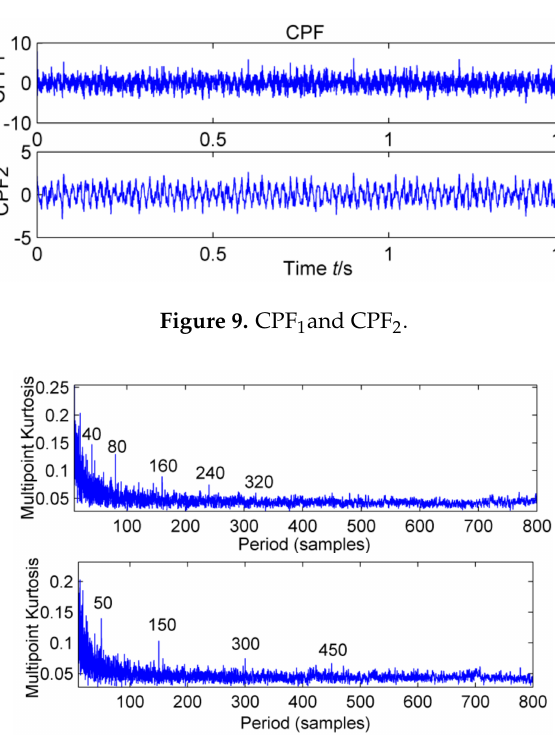
Figure 10. Multi-point kurtosis spectra of CPF 1 and CPF 2 .